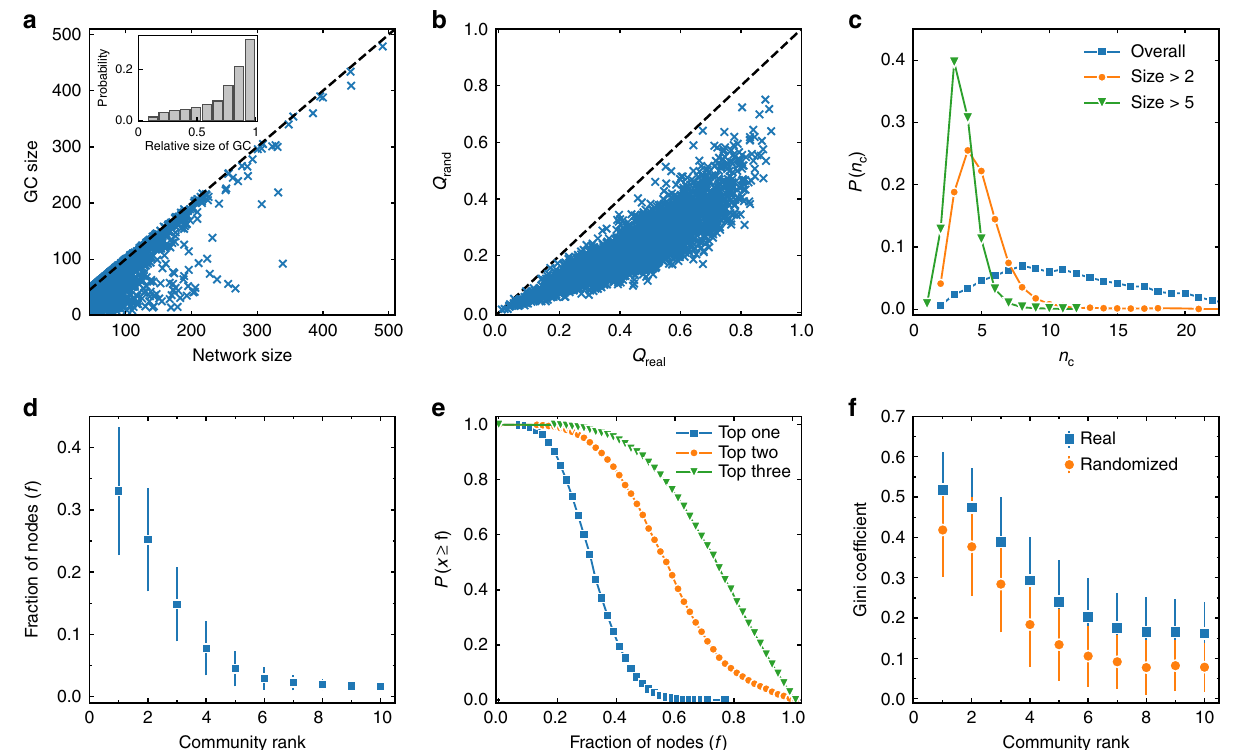
Fig. 2 Structural properties of co-citing networks. a The size of the co-citing network (CCN) versus the size of CCN ’ s giant component (GC). Each point represents a scientist. Most of the points are located below but close to the diagonal line, indicating that CCNs are in general connected and have relatively large GCs. This is supported by the inset where the distribution of the relative size of GC is presented. b The maximized modularity in real CCNs ( Q real ) and the maximized modularity in their degree-preserved reshuf fl ed counterparts ( Q rand ). All the points are located under the diagonal line, indicating that the community structure in real networks is truly signi fi cant. c The distribution of the number of communities ( n c ) for all scientists. Three curves are presented where all communities are taken into account (legend as all communities), small communities with less than 3 nodes are eliminated (legend as size > 2), and small communities with less than 6 nodes are eliminated (legend as size > 5). d Fraction of papers in different communities. e Inverse cumulative probability of fraction of nodes in the biggest community (legend as top one), the two largest communities (legend as top two), and the three largest communities (legend as top three), respectively. f The Gini coef fi cient of the distribution of PACS codes in different communities. Communities are ranked by size in descending order. A larger Gini coef fi cient corresponds to a more heterogeneous distribution, suggesting that higher fraction of papers in a community share the same PACS codes. The real data are compared with a random counterpart, where the PACS codes are reshuf fl ed among each individual scientist ’ s papers while the community structure is preserved. The error bars in this fi gure represent standard